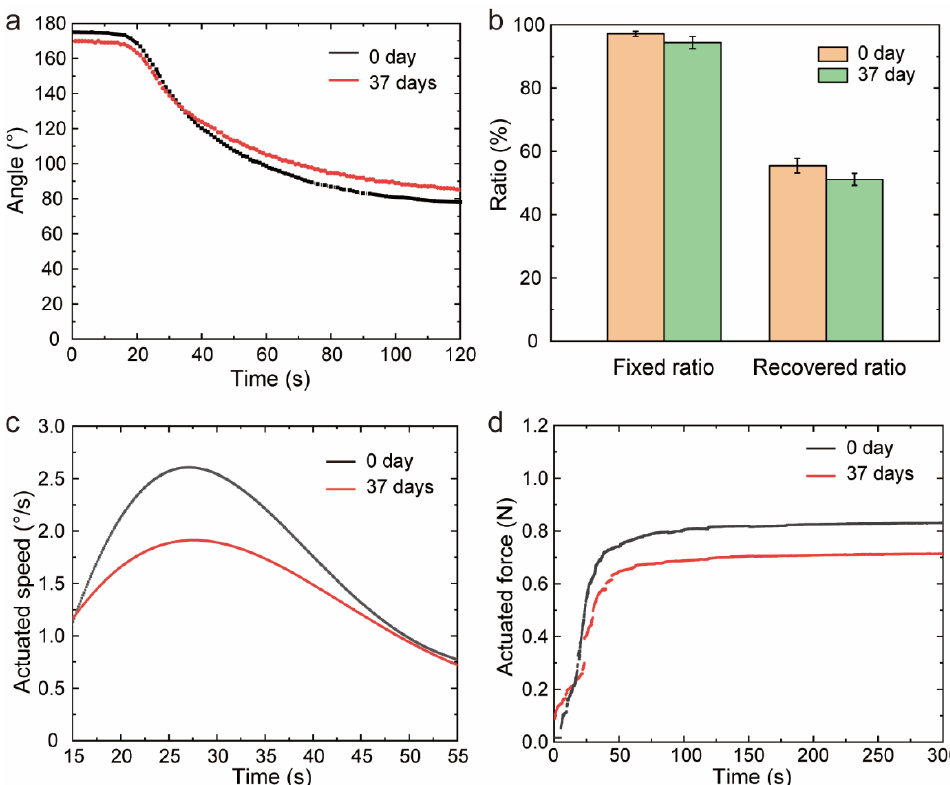
Figure 5. The effect of idling time on shape memory properties and actuation performances. ( a ) The variation in angle for the different idling time. ( b ) The shape memory properties for different idling time. ( c ) The angular speed for the different idling time. ( d ) The recovery force for different idling